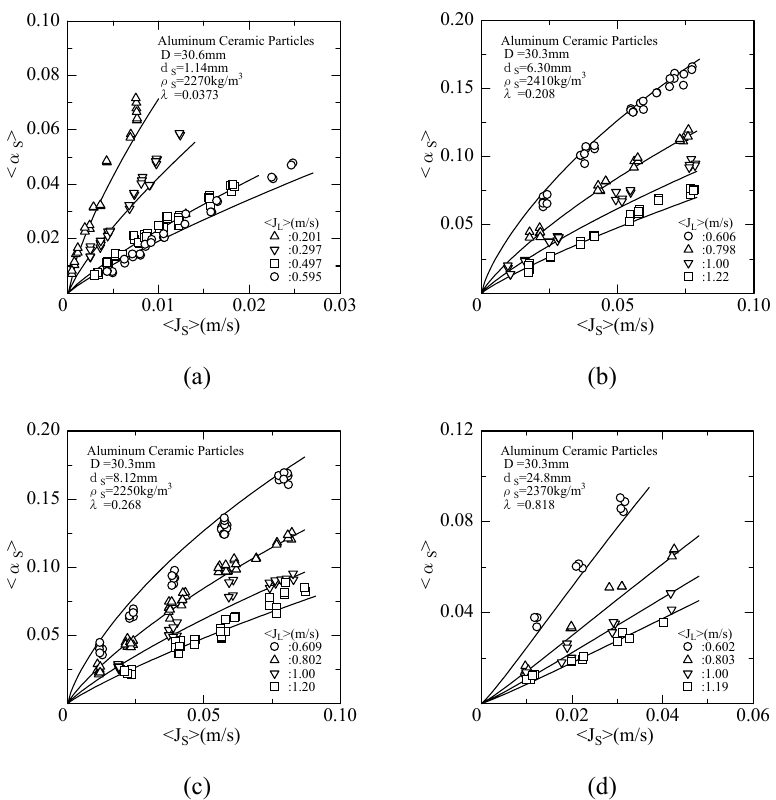
Fig.6 Estimated values of solid volume fraction of solid-liquid two-phase flow > Table 1 shows a summary of the quantitative evaluation. The estimated values of < α S are classified into three groups. The first group consists of the results for all of the experimental data obtained at Kobe University (1,3,4) . The mean particle diameters d were S 1.14, 2.57, 4.17, 6.30, 8.12, 12.9, 17.8, and 24.8 mm. The pipe diameters D were D = 20.9, 30.6/30.3, and 50.4 mm. All particles were made of aluminum ceramics, and their densities were between 2,250 and 2,410 kg/m 3 . The number of data was 1,677. The second group (4) consists of 1,234 data points for the particles of d < 6 mm, D = 20.9, 30.6, and 50.4 mm S and 0 < λ < 0.2, so that the wall effect on the relative velocities in this group are not so dominant. The last group consists of 443 data points for coarse particles of d > 6 mm, D = S 30.3 mm, and 0.2 < λ < 0.82. The table shows the average values, Ave , of the